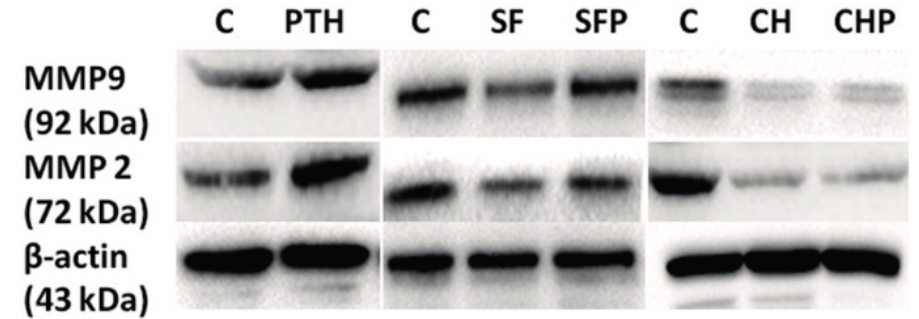
Figure 4. PTH could regulate MMP2 and MMP9 proteins expression by primary